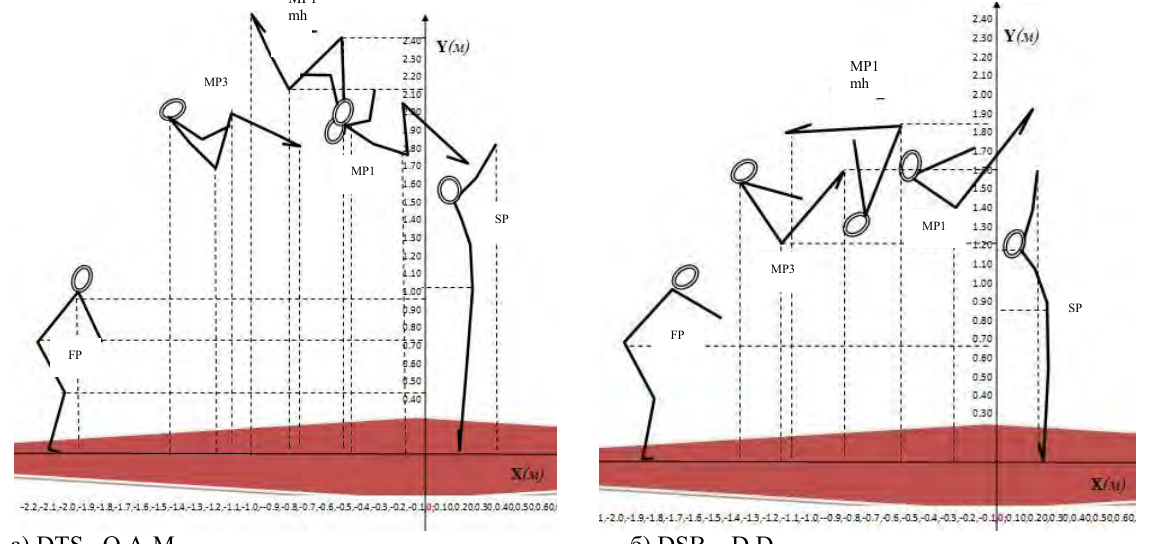
Fig.1. Key elements of sport technique of DST and DBS acrobatic jumps sport techniques in FX routine: а) О.А.М – DTS, b) D.D. – DBS – final participants of sport gymnastics championship, Rumania, 2012 in FX routine (legend, see